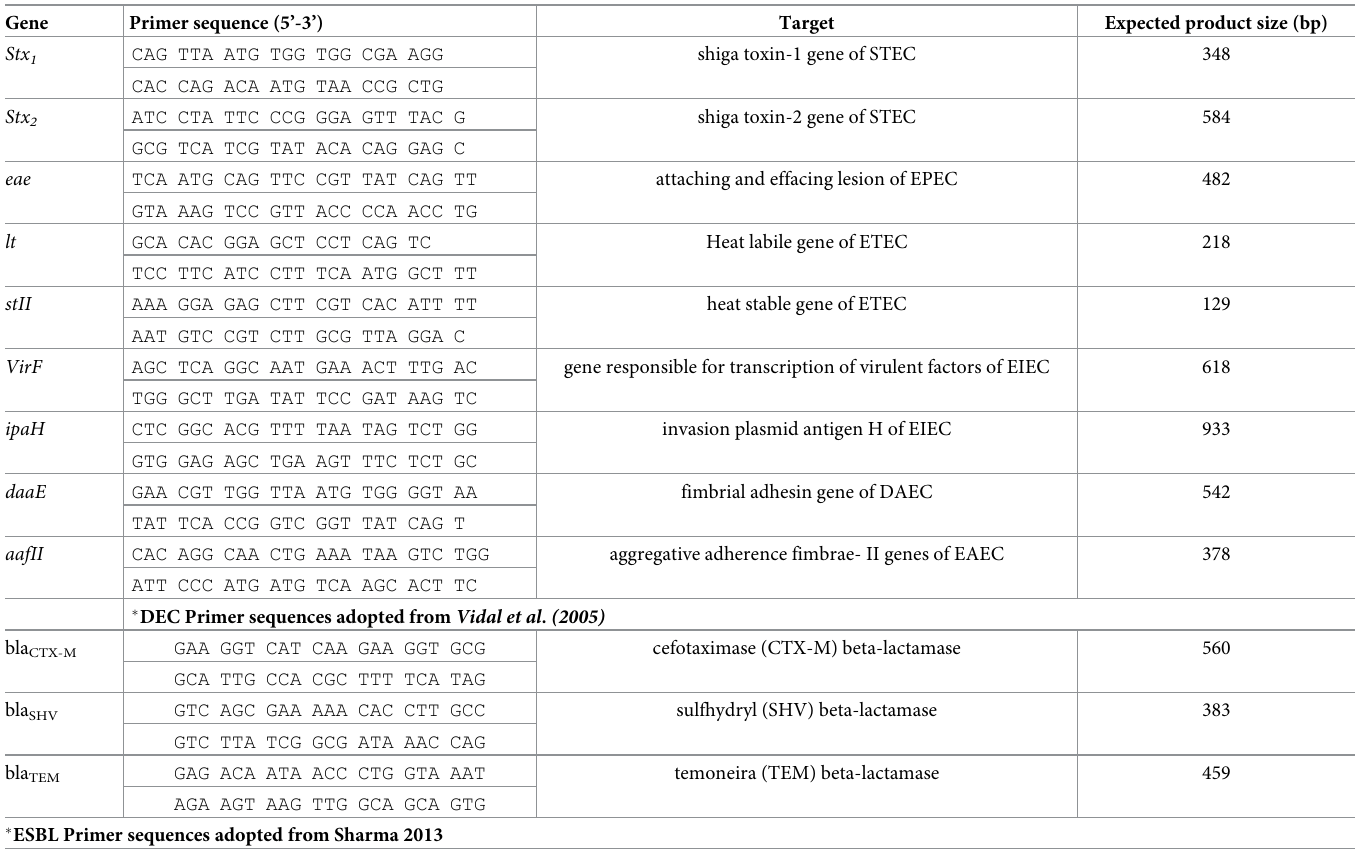
Table 1. DEC and ESBL primer sequence